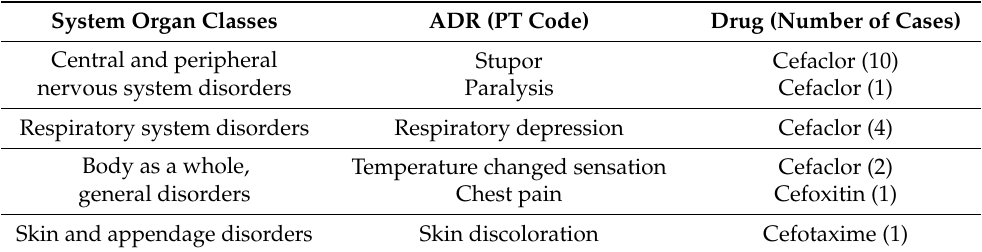
Table 3. Serious AEs unlisted on the drug labels. System Organ Classes ADR (PT Code) Drug (Number of Cases) Central and peripheral Stupor Cefaclor (10) nervous system disorders Paralysis Cefaclor (1) Respiratory system disorders Respiratory depression Cefaclor (4) Body as a whole, Temperature changed sensation Cefaclor (2) general disorders Chest pain Cefoxitin (1) Skin and appendage disorders Skin discoloration Cefotaxime (1) ADR, adverse drug reaction; PT, preferred term.